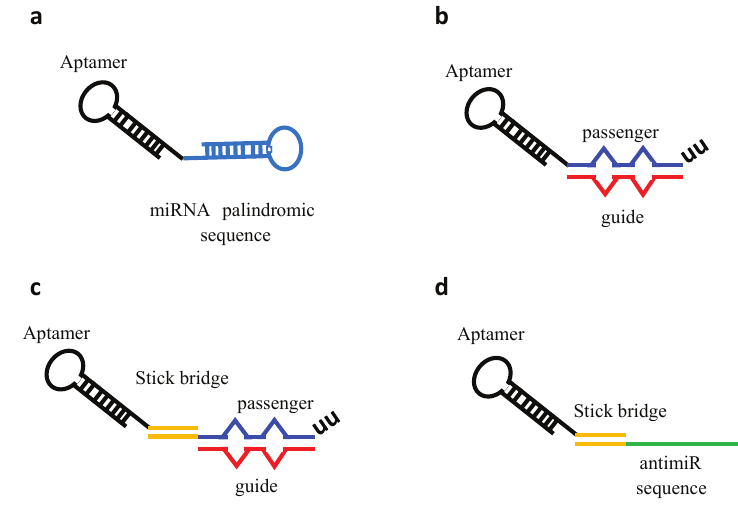
Figure 5. Aptamer–miRNA/antimiR conjugates. Schematic representation of different conjugation strategies adopted. ( a ) Aptamer covalently conjugated to a miRNA palindromic sequence. ( b ) Aptamer directly conjugated with the miRNA passenger strand followed by the annealing of the miRNA guide strand. The miRNA duplex contains internal partial complementarity and increased length extension (27/26 bases) to obtain a more effective Dicer substrate. ( c ) Stick-based approach in which the aptamer and the miRNA moieties are connected through the annealing of complementary GC-rich stick sequences. ( d ) Stick-based approach in which the aptamer and the antimiR are connected through the annealing of complementary GC-rich stick